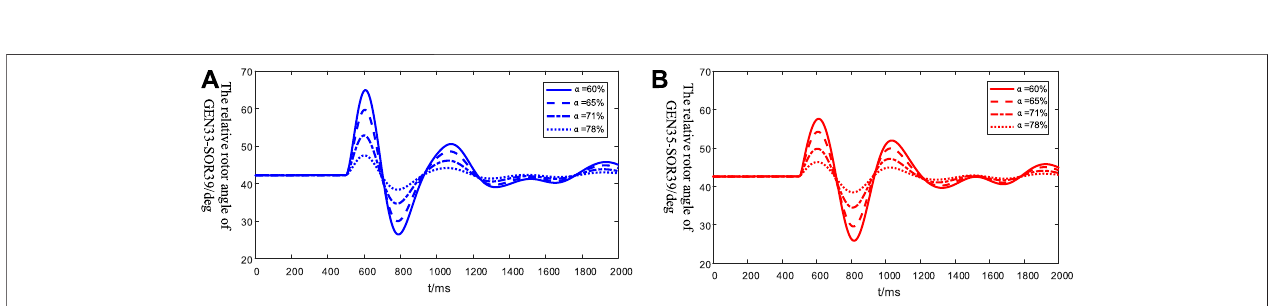
FIGURE 14 | Relative angle curve under different DC power transmission ratio (A) The relative angle curve of GEN_33-SOR_39 (B) The relative angle curve of GEN_35-SOR_39.